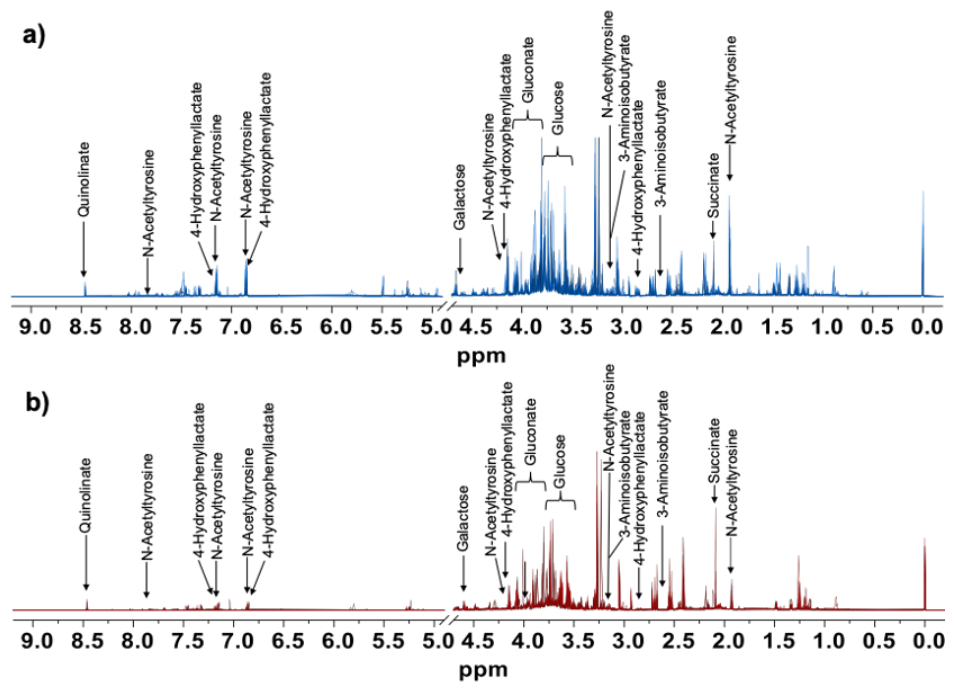
Figure 2. Overlay of 12 stacked 1 H NMR spectra (700 MHz, 298 K, D 2 O (KH 2 PO 4 , pH 7.4) normalized to the total area of the urine samples of preterm newborns who received ( a ) PN or ( b ) EN. Some metabolites are shown on top of each spectrum.